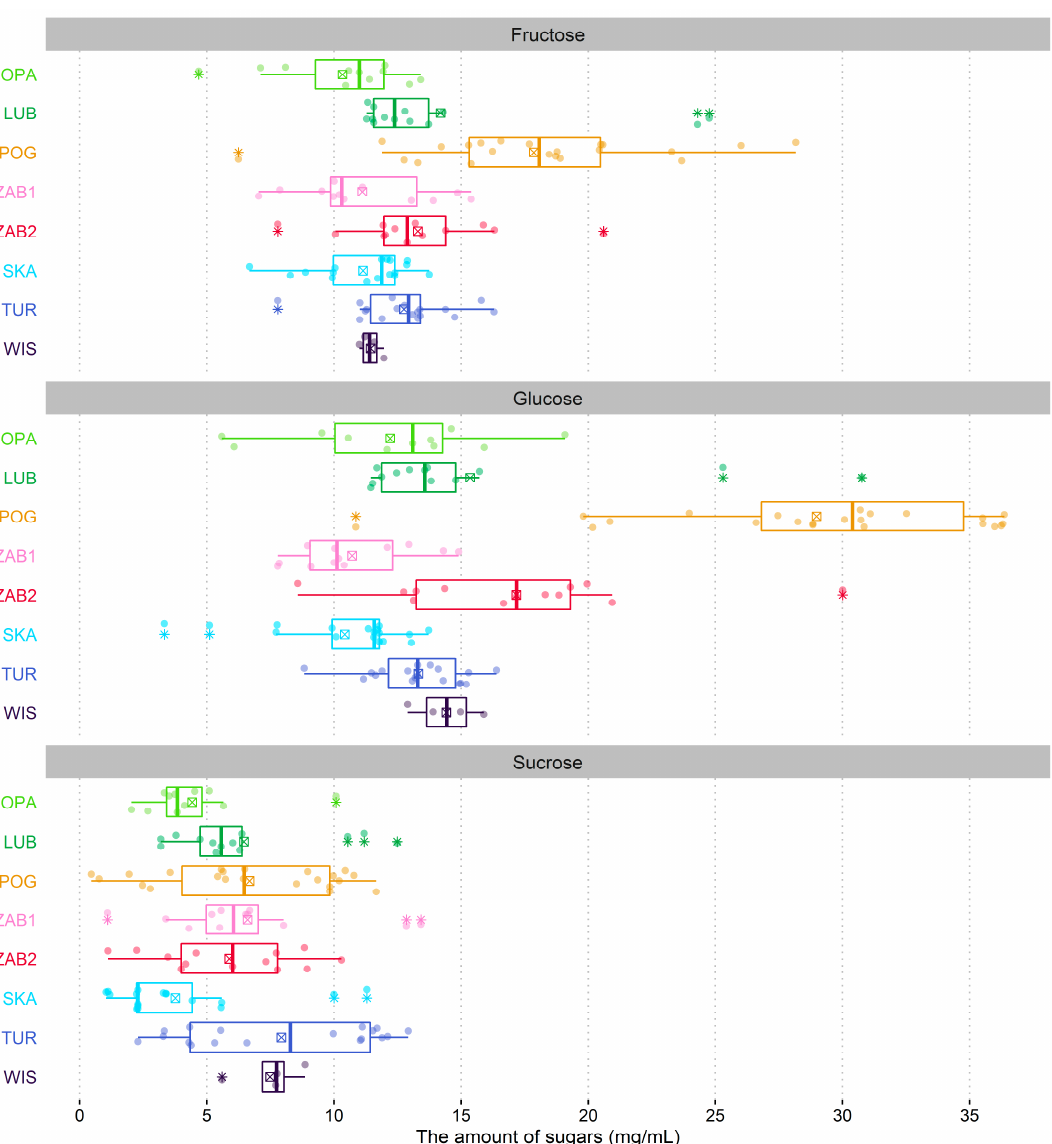
Figure 1. Boxplots of sugar amounts for Neottia ovata populations. Colored dots are individual samples. The crossed square shows the mean. The lower and upper hinges correspond to the lower (Q1) and upper (Q3) quartiles. Thus box length shows the interquartile range (IQR). The thicker line inside boxes corresponds to the median. The lower whisker extends from the hinge to the smallest value at most Q1 − 1.5 × IQR of the hinge. The upper whisker extends from the hinge to the largest value no further than Q3 + 1.5 × IQR. Data beyond the end of the whiskers, indicated with an asterisk symbol, are